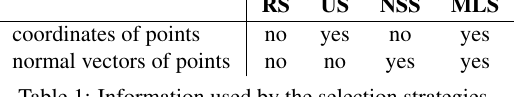
Table 1: Information used by the selection